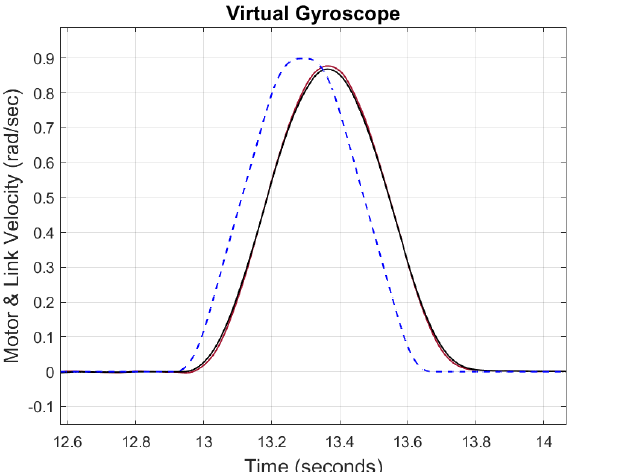
Figure 24. Velocity reference (dashed blue line), motor velocity (black line), link estimated velocity (dark red line) for a single